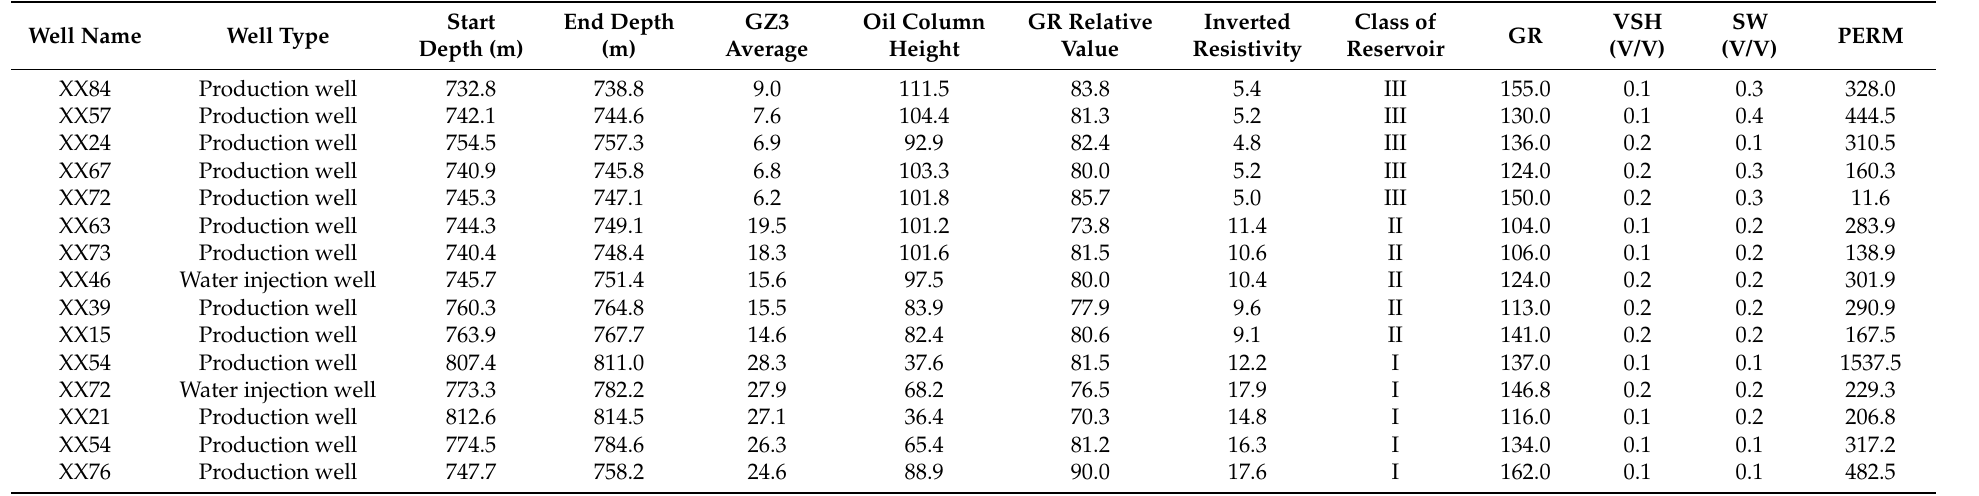
Table 3. Partial logging interpretation data of 502 wells in the P